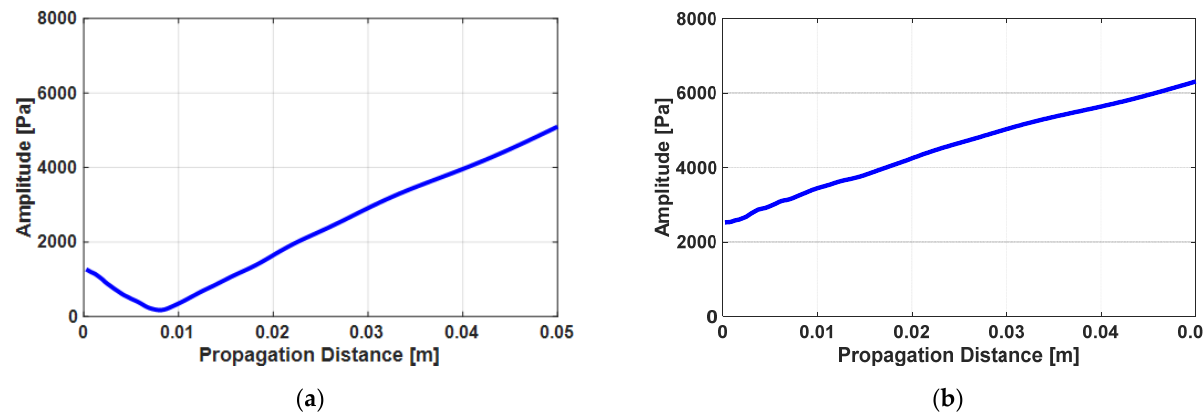
Figure 5. Received pressure amplitude of the second harmonic wave calculated using Equation (7) at the frequency 10 MHz including the incident second harmonic wave in two cases: ( a ) the opposite phase (fused silica) and ( b ) the same phase (Al6061-T6).